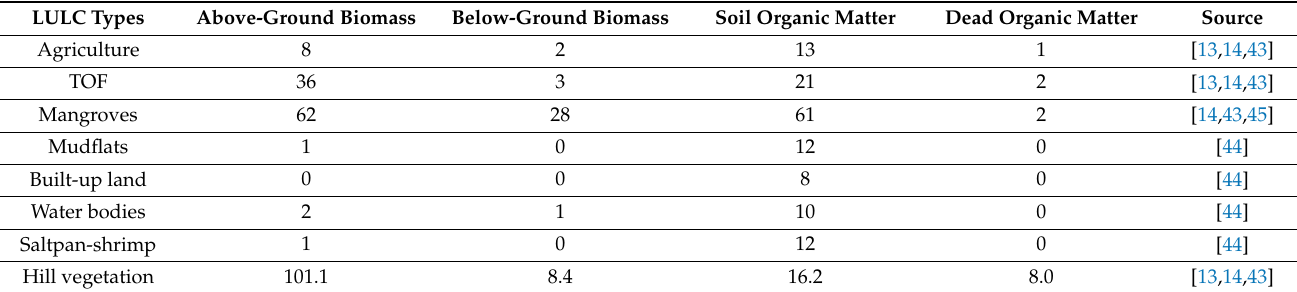
Table 2. Carbon densities (Mg/ha) for different LULC types.